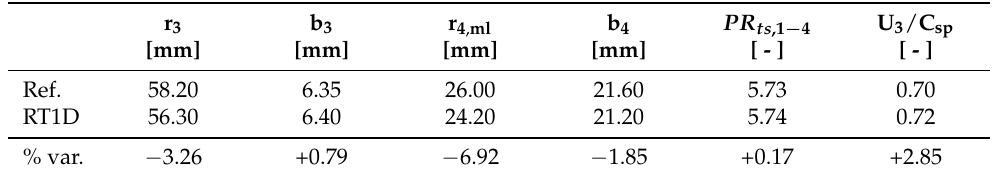
Table 6. Centripetal turbine design—procedure calibration [22]. Numeric convention is analogous to Figure 5.